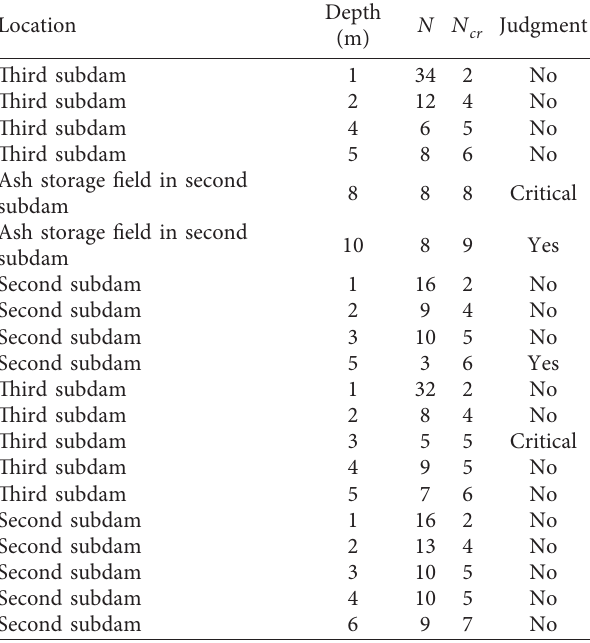
Table 2: Standard penetration test